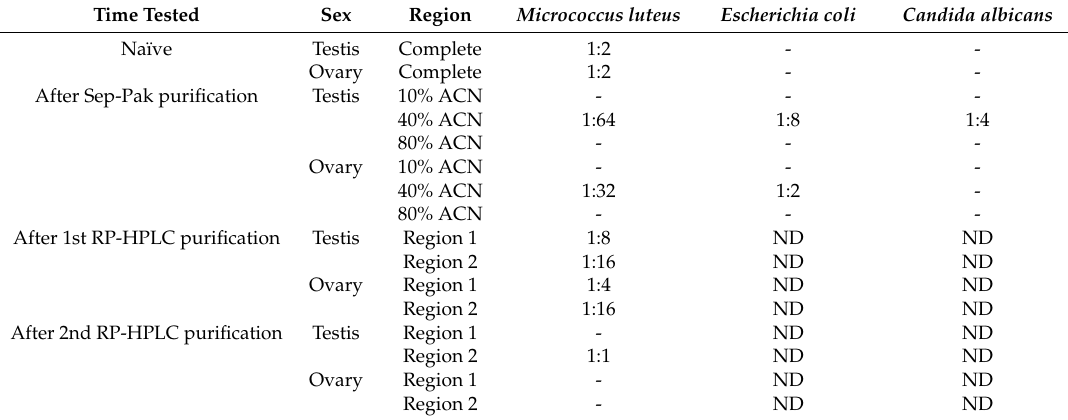
Table 1. Antimicrobial activity against Micrococcus luteus , Escherichia coli , or Candida albicans in ovary or testis from adult European sea bass healthy specimens. Lowest serial dilution of samples with antimicrobial activity is shown. RP-HPLC, reverse phase high-performance liquid chromatography; ACN, acetonitrile; middle script (-), non-detected activity; ND, not determined. To see equivalence of regions, see Figure